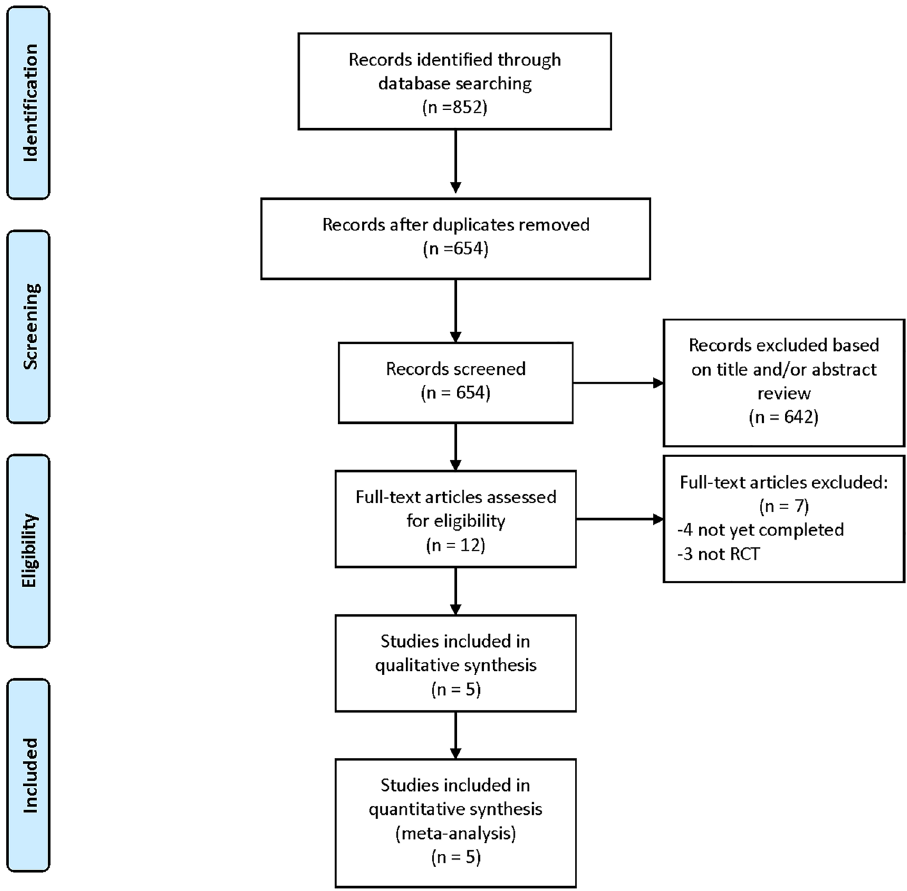
Figure 1. Study search diagram.